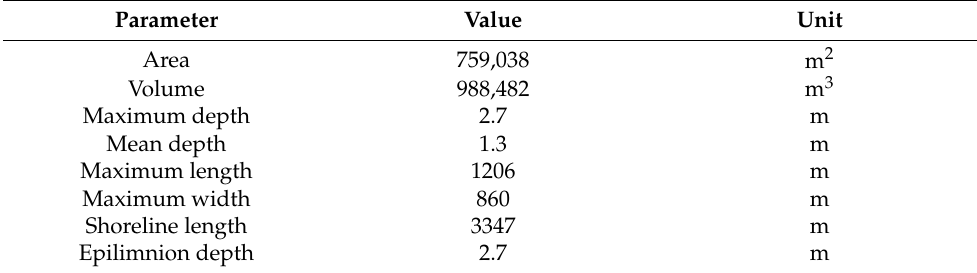
Table 1. Morphometry of Lake Bikcze.